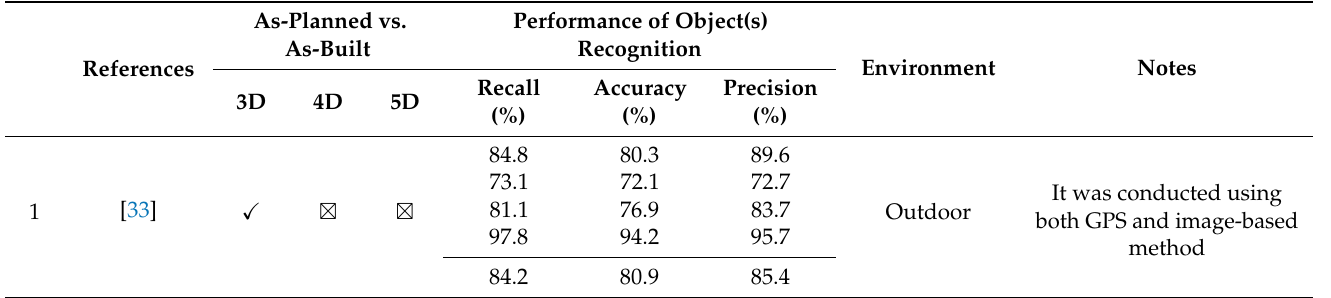
Table 4. Studies of GPS integrated with BIM in CPM: